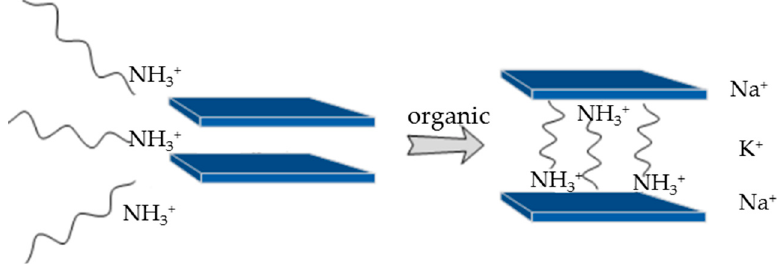
Figure 2. Diagram of the alkyl ammonium salt’s modification effects on MMT.